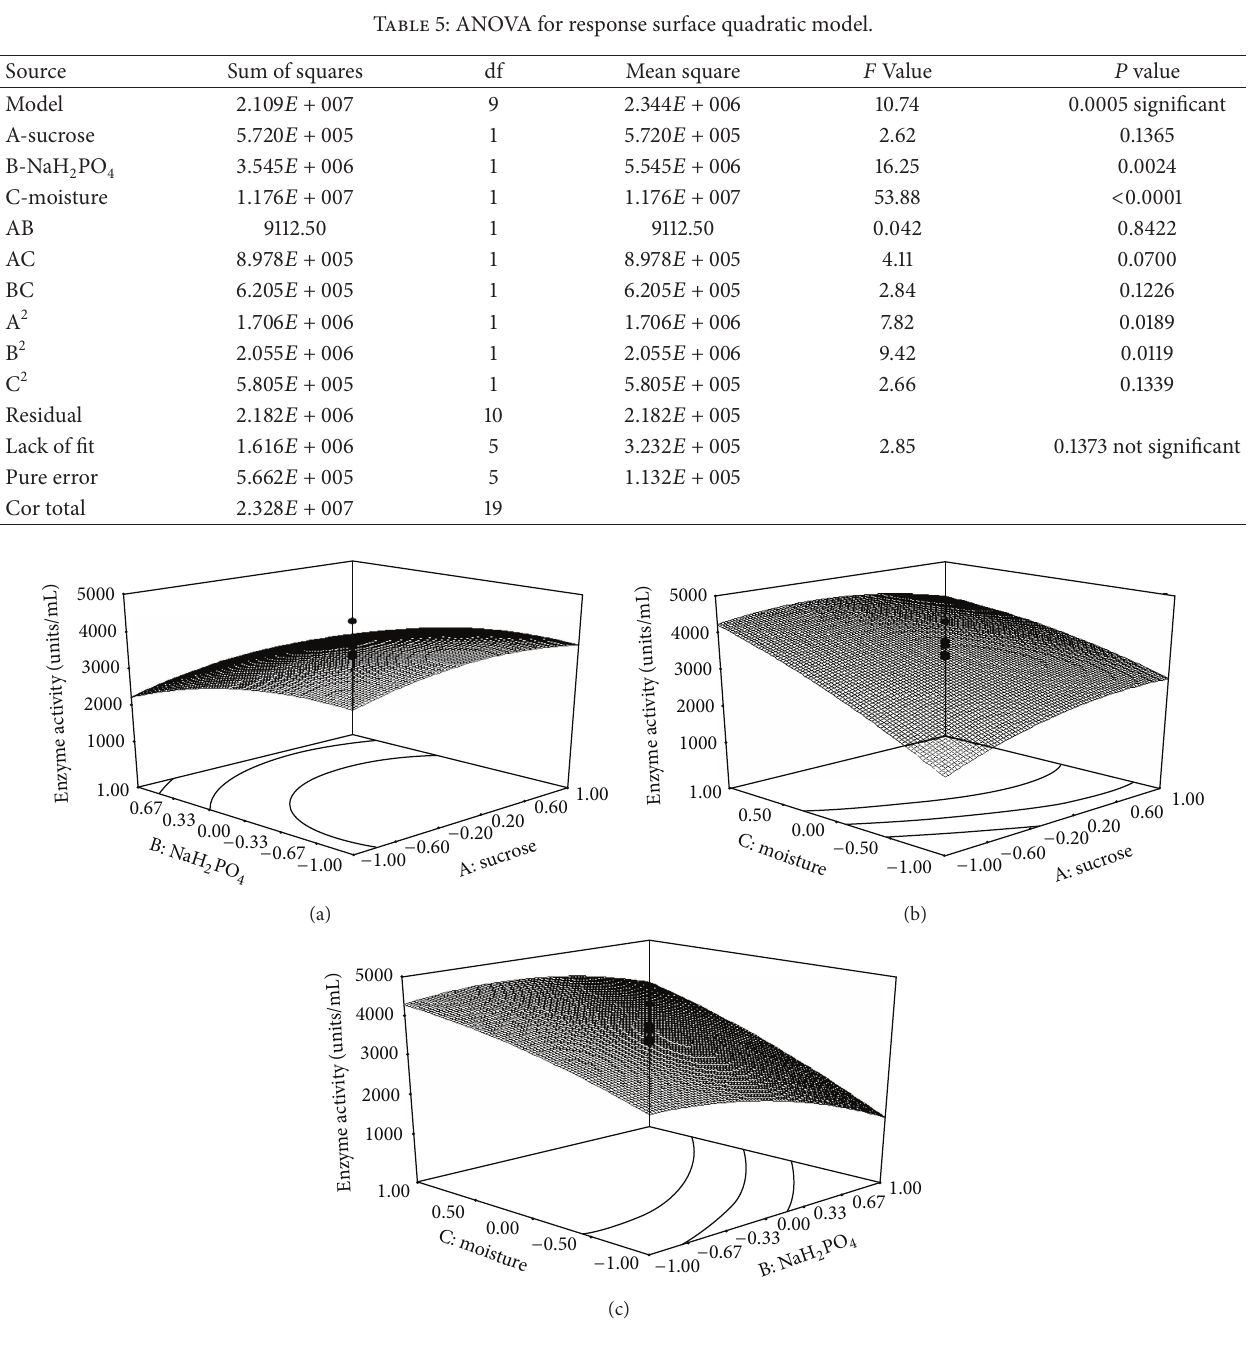
Figure3:(a)–(c)ResponsesurfaceplotsshowingtheeffectofinteractionofsucroseandNaH 2 PO 4 (a),sucroseandmoisture(b),andmoisture and NaH 2 PO 4